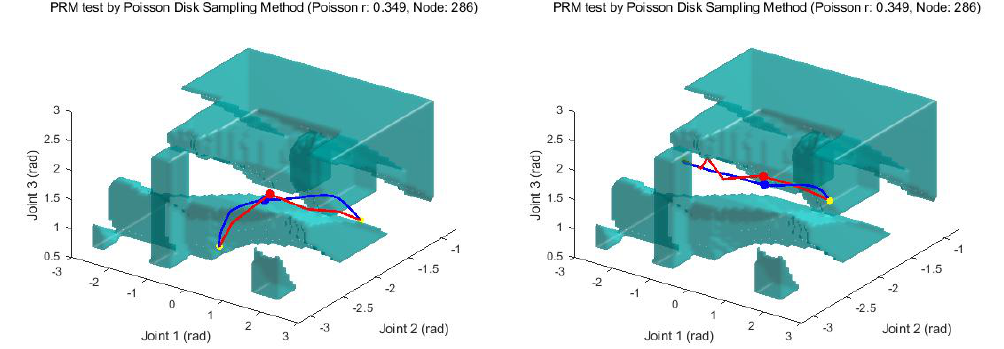
Figure 11. Path generation using DDPG with HER.